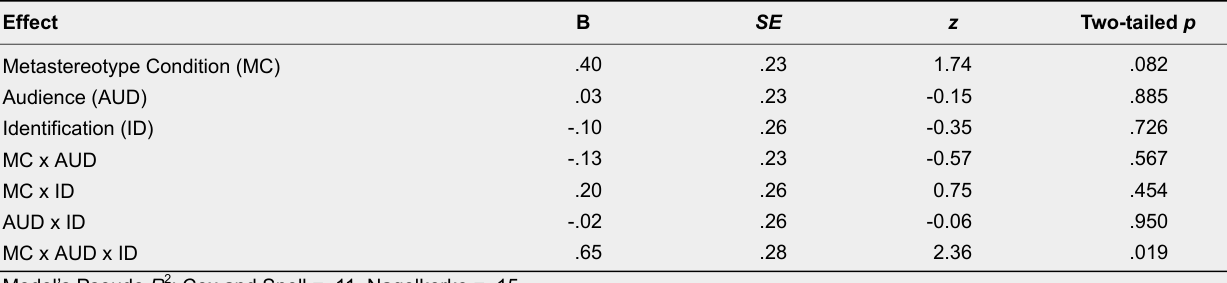
Multiple Logistic Regression Model Results for the Effects of Metastereotype Condition, Audience Group Membership, and Ingroup Identification on Pledge to Help the Outgroup